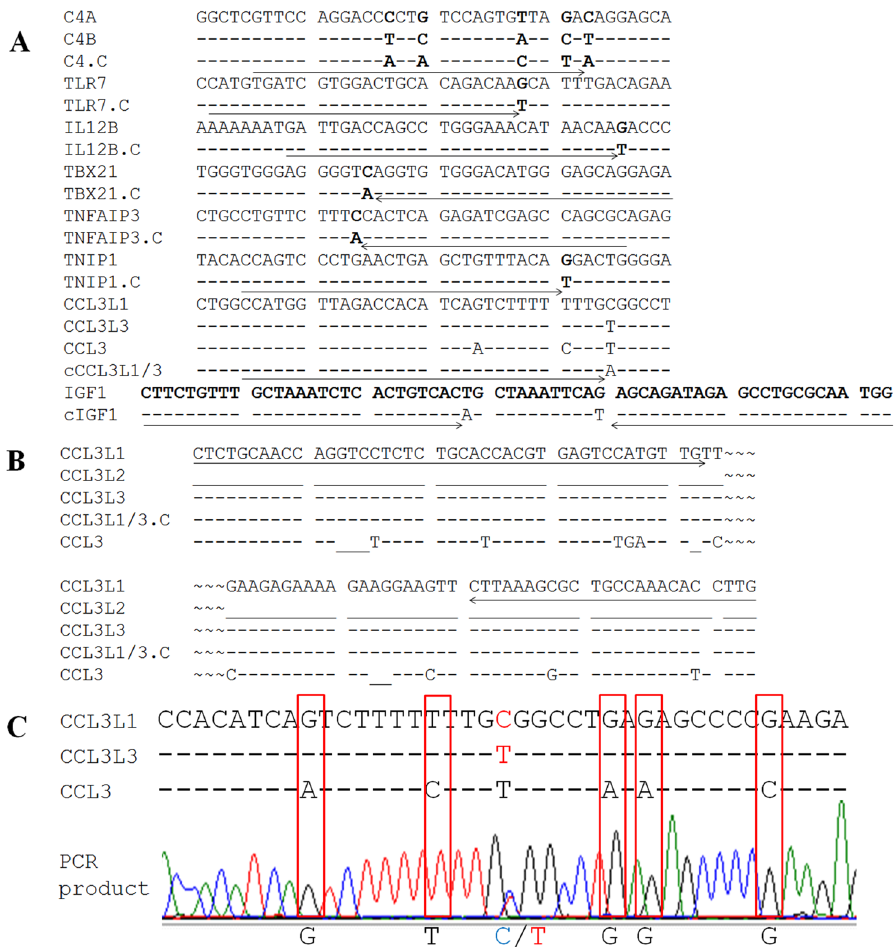
Figure 1. Alignments of C4 , TLR7 , IL12B , TBX21 , TNFAIP3 , TNIP , and CCL3L sequences for the mrcPCR assay. ( A ) Alignment of reference and competitor sequences for C4 , TLR7 , IL12B , TBX21 , TNFAIP3 , TNIP , and IGF1 . ( B ) Alignment of reference and competitor sequences for the PCR primer sites of the CCL3L family. CCL3L1 , CCL3L2 , CCL3L3 , and CCL3 are CCL3L family genes. For ( B ) and ( C ), the same bases as those in the reference sequences are marked by “–,” the absence of a base in the sequence is marked by “_,” and the competitor sequences are named by adding ‘.C’ after the gene name. The PCR primers and extension primers for the mrcPCR assays are marked by arrows. The space sequence for the forward primers and reverse primers for the CCL3L family genes are marked by “~~~”. ( C ) Sanger sequencing of PCR products to confirm the specific amplification of CCL3L1 and CCL3L3 by the mrcPCR assay. Bases specific for CCL3 were not observed in mrcPCR assay PCR product (red